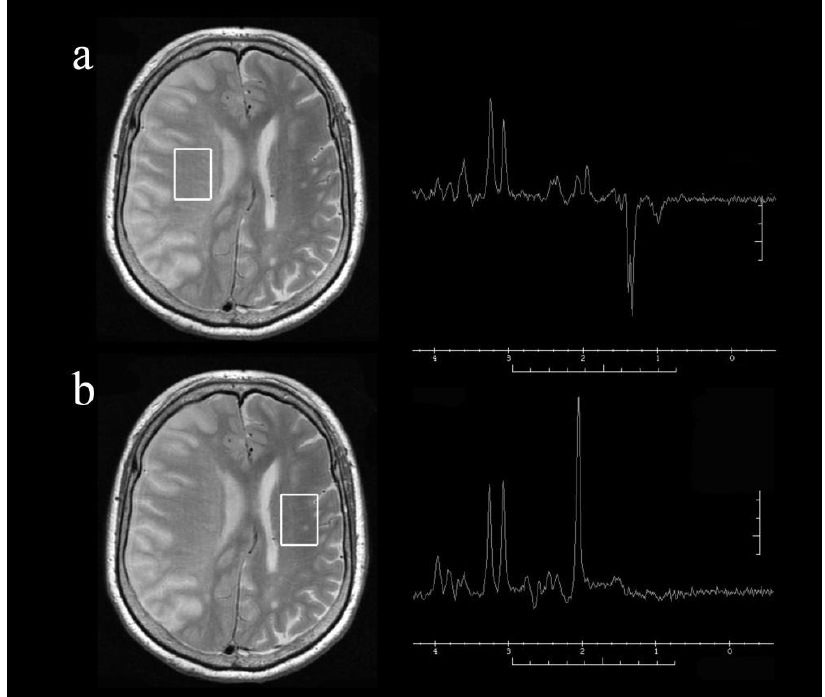
Figure 1. Representative axial T2-weighted magnetic resonance images and single-voxel proton magnetic resonance spectra obtained from the voxels of interest (square areas) in the infarct hemisphere ( a ) and normal hemisphere ( b ) of a patient with right internal carotid artery occlusion at 24 h after onset. Note the presence of lactate with relatively preserved N -acetyl aspartate (NAA) in the infarct hemisphere.